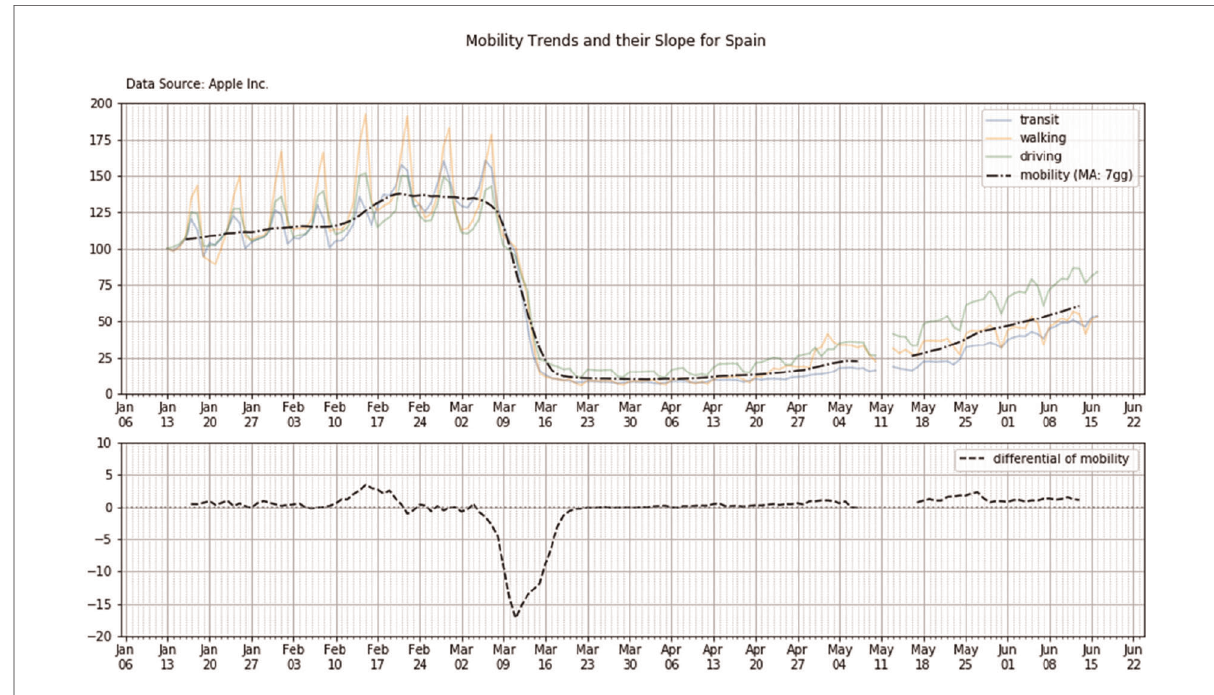
FIGURE 4 Top panel — the 7-days rolling average mobility as extracted from the original data set provided by Apple: the residential mobility trends are averaged and then smoothed (black dotted line). Bottom panel — the derivative of the 7-days rolling average curve — Country: